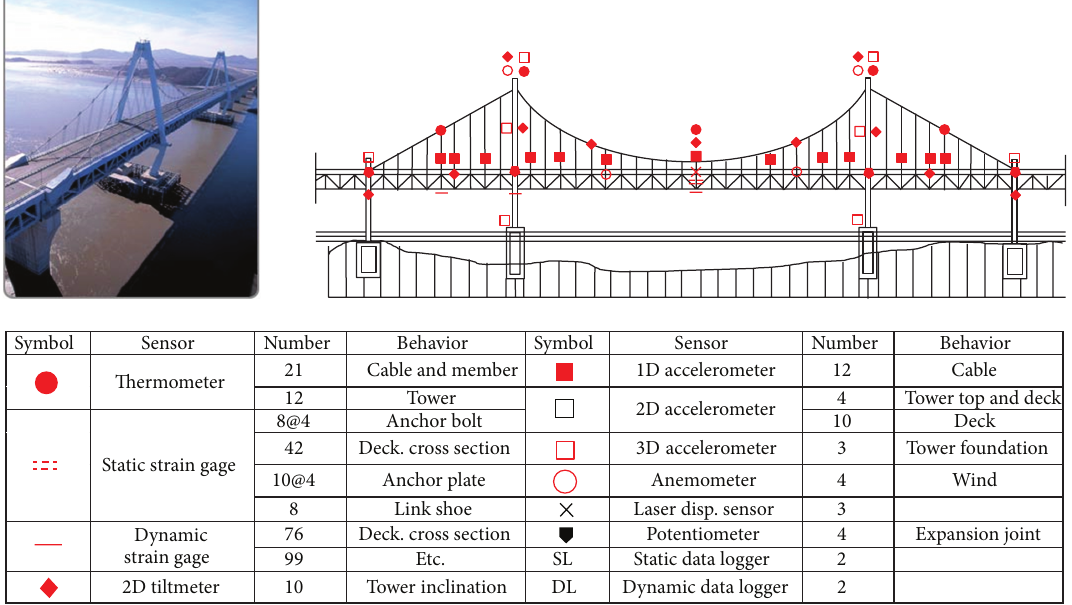
Figure 4: Structural health monitoring system of the Yeong-Jong Bridge in